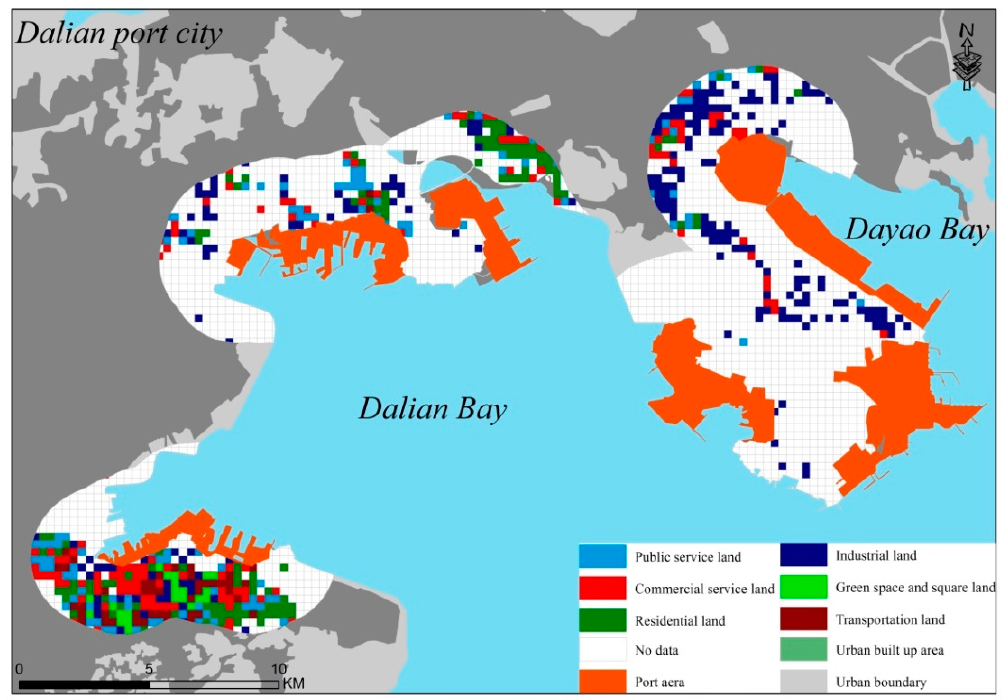
Figure 10. Distribution of urban functional areas on the Dalian port–city interface (source: drawn by author).